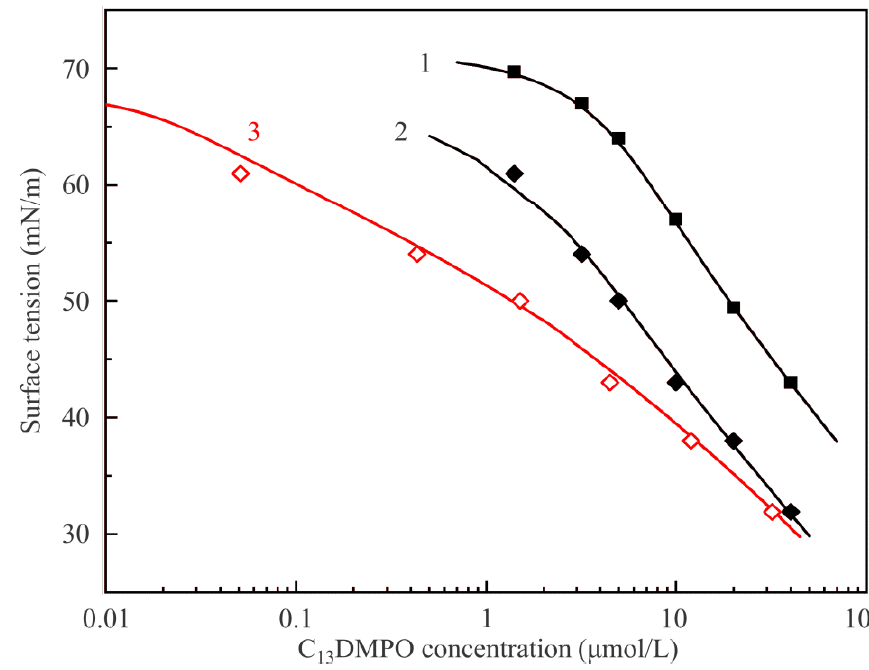
Figure 6. Equilibrium surface tension isotherms of C 13 DMPO aqueous solutions at the interfaces with air and hexane vapor. For details see text.